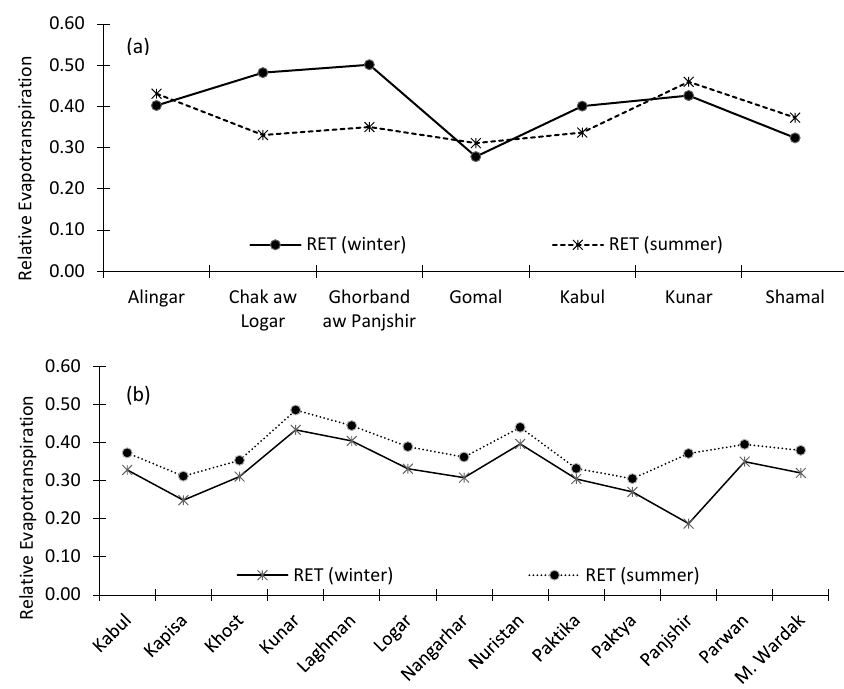
Figure 11. Inter-seasonal distribution of relative evapotranspiration across ( a ) sub-basins and ( b ) provinces of the Kabul River Basin in winter and summer seasons.